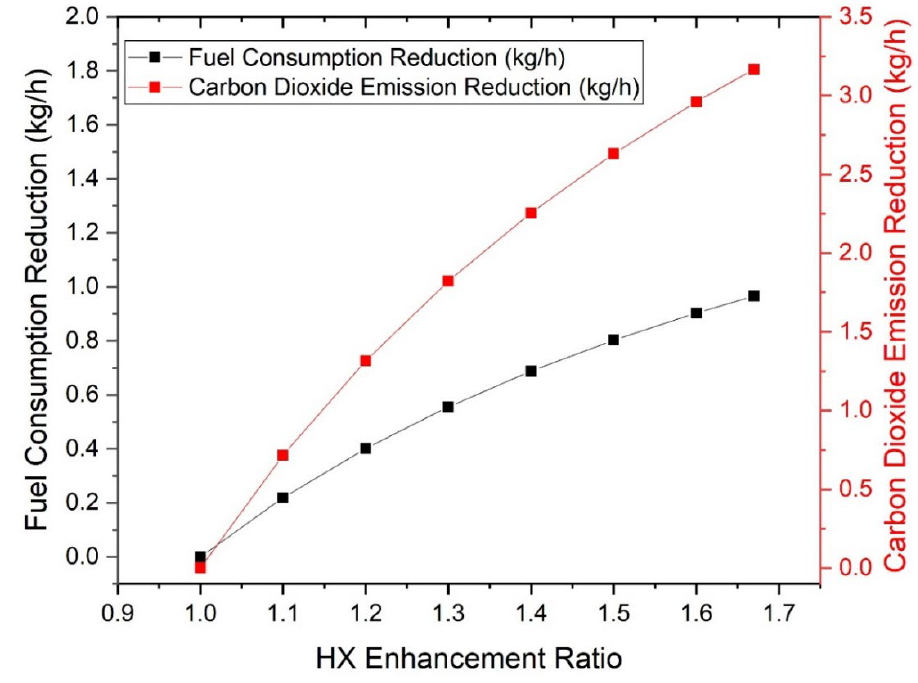
Figure 15. Variation of the fuel consumption and carbon dioxide emission rates in function of the enhancement percentage of the HX thermal performance.